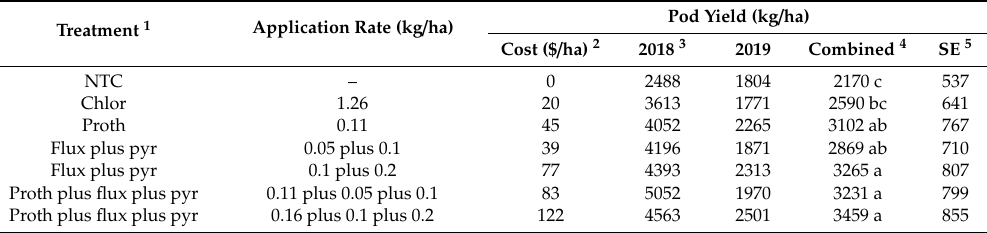
Table 3. Peanut pod yield associated with fungicide treatments from field experiments conducted in Blackville, SC, from 2018 to